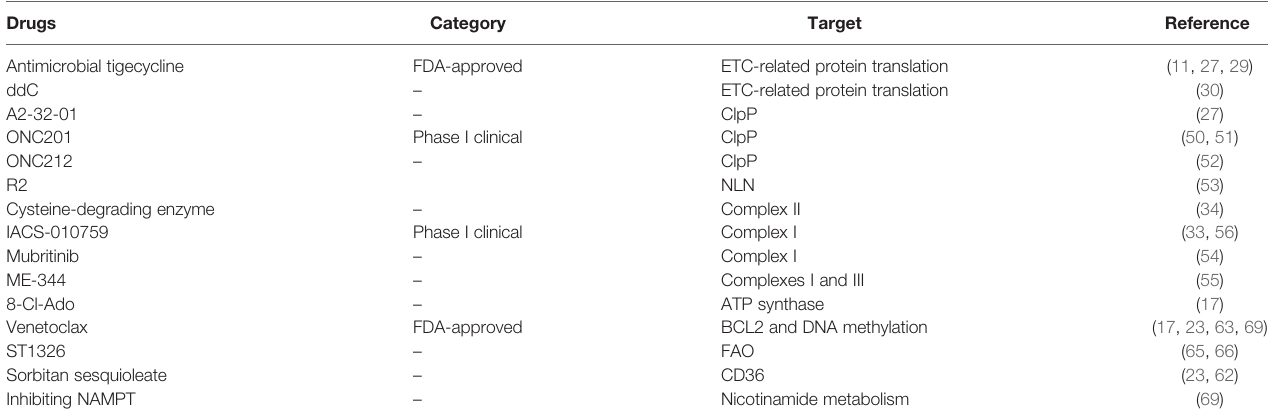
TABLE 1 | Modulators of OXPHOS in